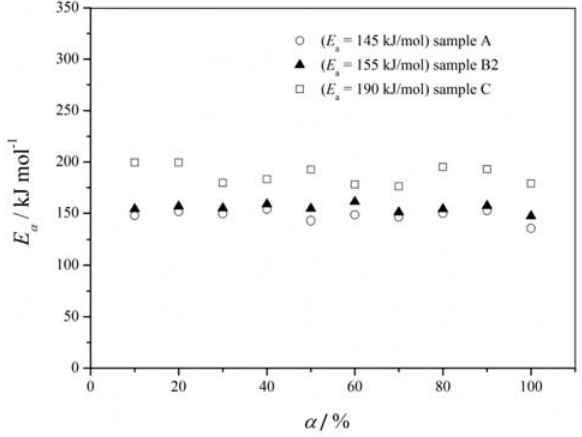
Figure 6. E vs α relationship for PMMA or PMMA-composites a thermal decomposition